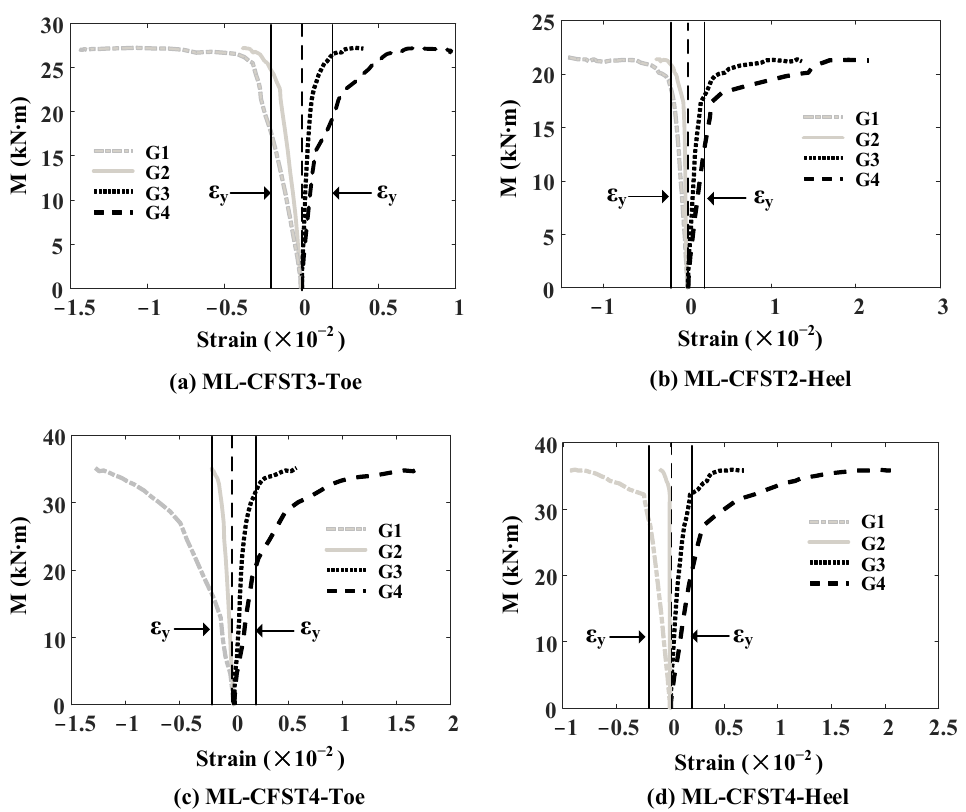
Figure 16. Longitudinal strain ( ε ) versus bending moment (M) curves: ( a ) ML-CFST3-Toe; ( b ) ML- CFST2-Heel; ( c ) ML-CFST4-Toe; ( d ) ML-CFST4-Heel.